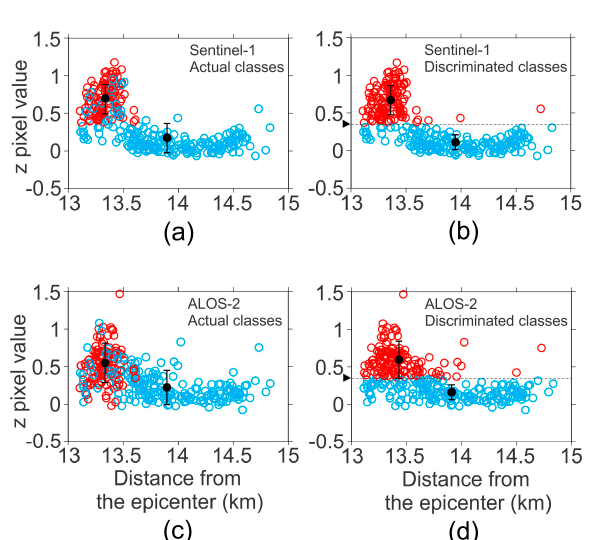
Figure 8. Comparison of the z discriminant score for each individual building and the corresponding distance from the epicenter: ( a ) for actual classes of the Sentinel-1 dataset; ( b ) for discriminated classes of the Sentinel-1 dataset; ( c ) for actual classes of the ALOS-2 dataset; ( d ) for discriminated classes of the ALOS-2 dataset. The solid black circles are average values, and the error bars are standard deviations. The black triangles in ( b , d ) are the cutoff points, deduced from relative discriminant analyses.